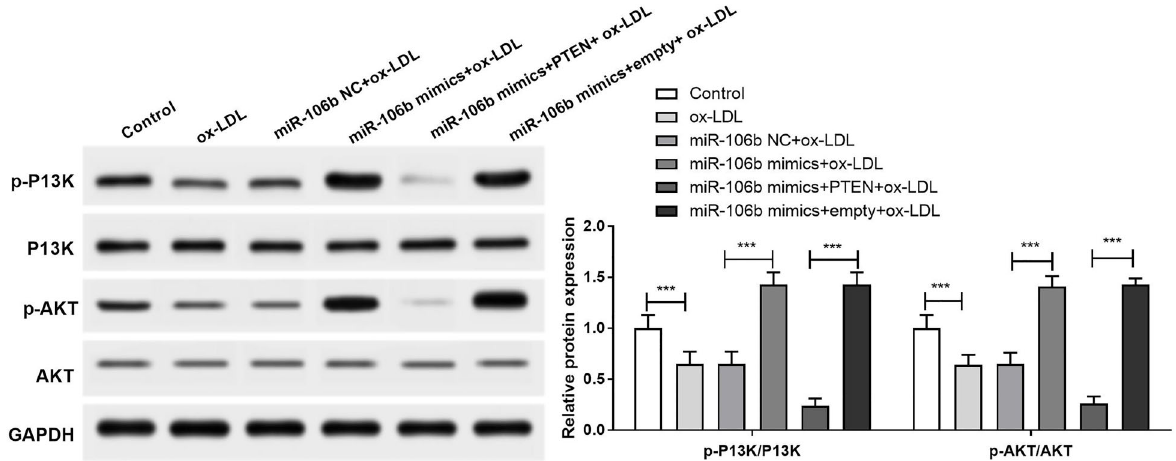
Figure 5. MiR-106b activated PI3K/AKT signaling pathway by down-regulating PTEN. Protein level of p-PI3K, total P13K, p-AKT, and total AKT was detected by western blot. Data are reported as means ± SD. ***P o 0.001 (ANOVA). ox-LDL: oxidized-low-density lipoproteins; NC: negative